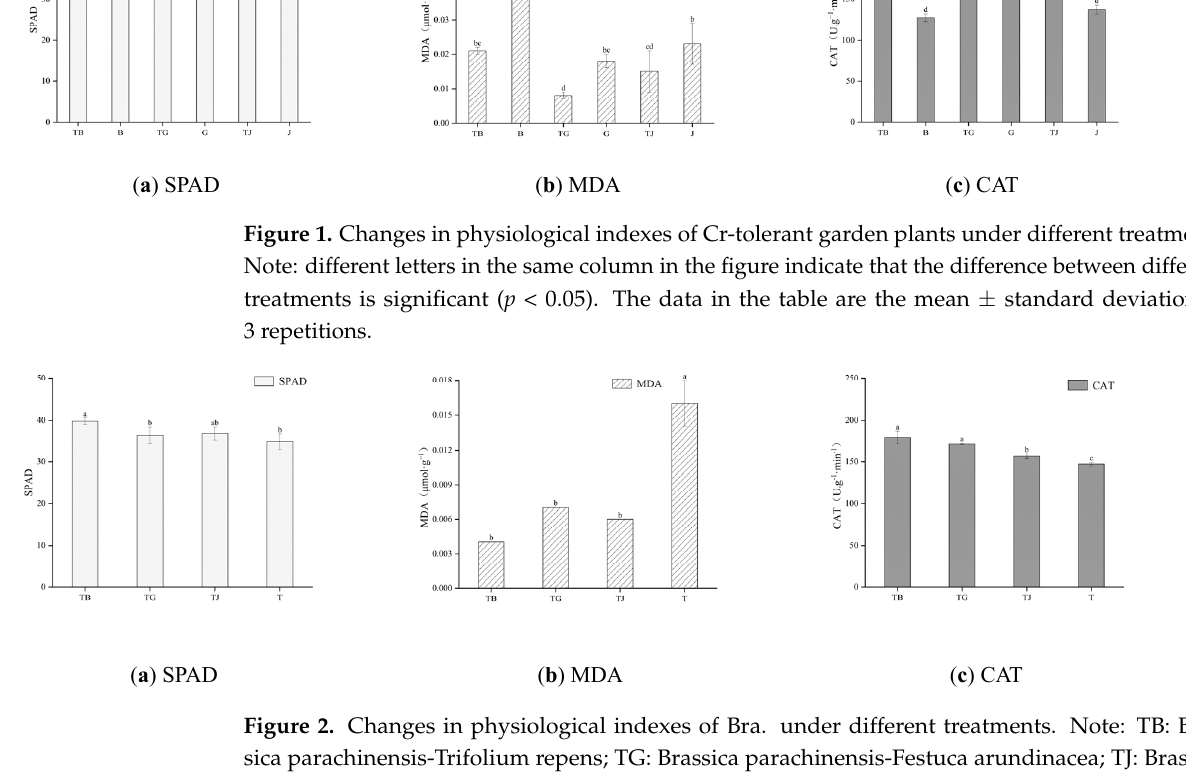
( b ) Cr-resistant garden plants Figure 3. Cr content of plants under different treatments. Note: different letters in the same column in the figure indicate that the difference between different treatments is significant ( p < 0.05). The data in the table are the mean ± standard deviation of 3 repetitions.